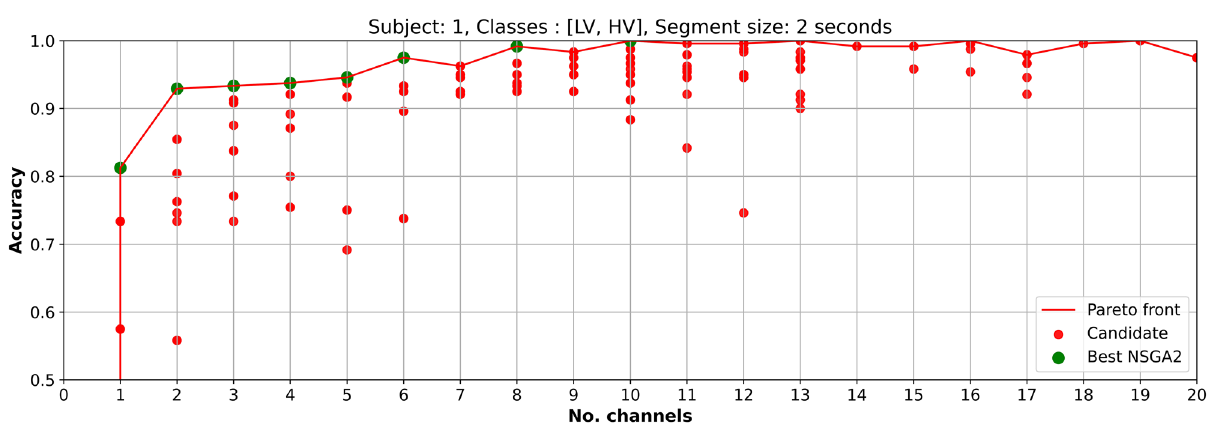
Figure 7. Optimized EEG channel selection results for low and high valence classification using EEGNet and data from subject